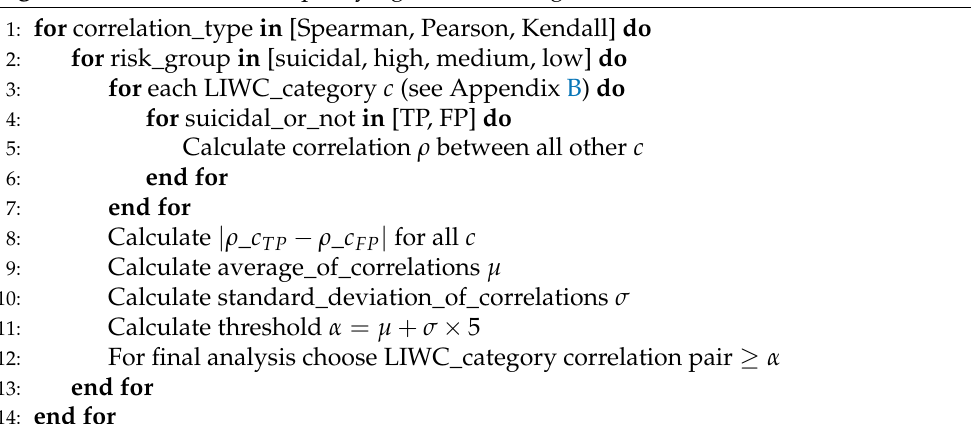
Algorithm 1 Procedure for specifying relevant